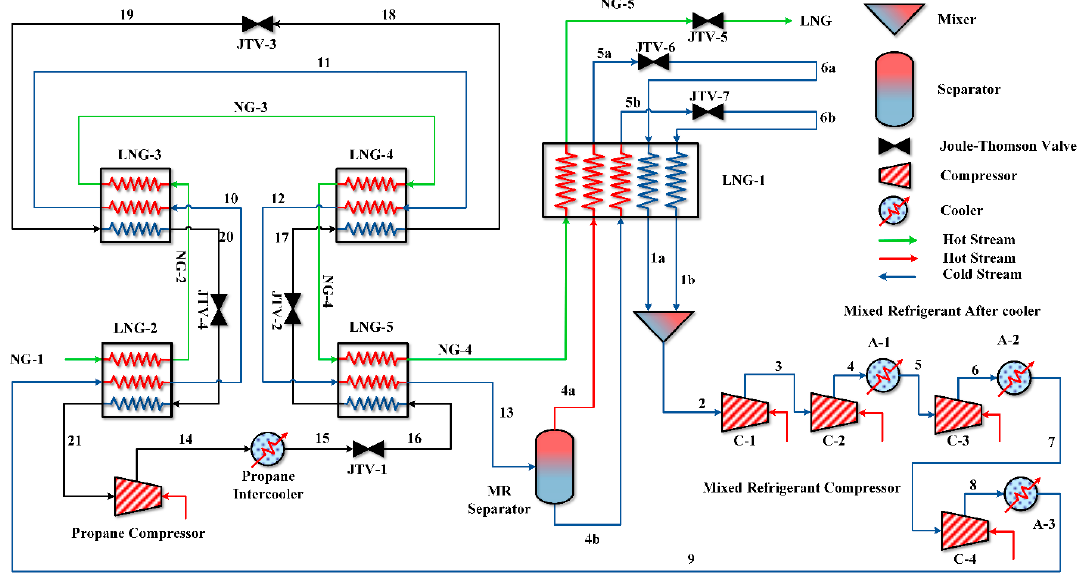
Figure 5. Process flow diagram of the propane-precooled mixed refrigerant (C3MR) process .